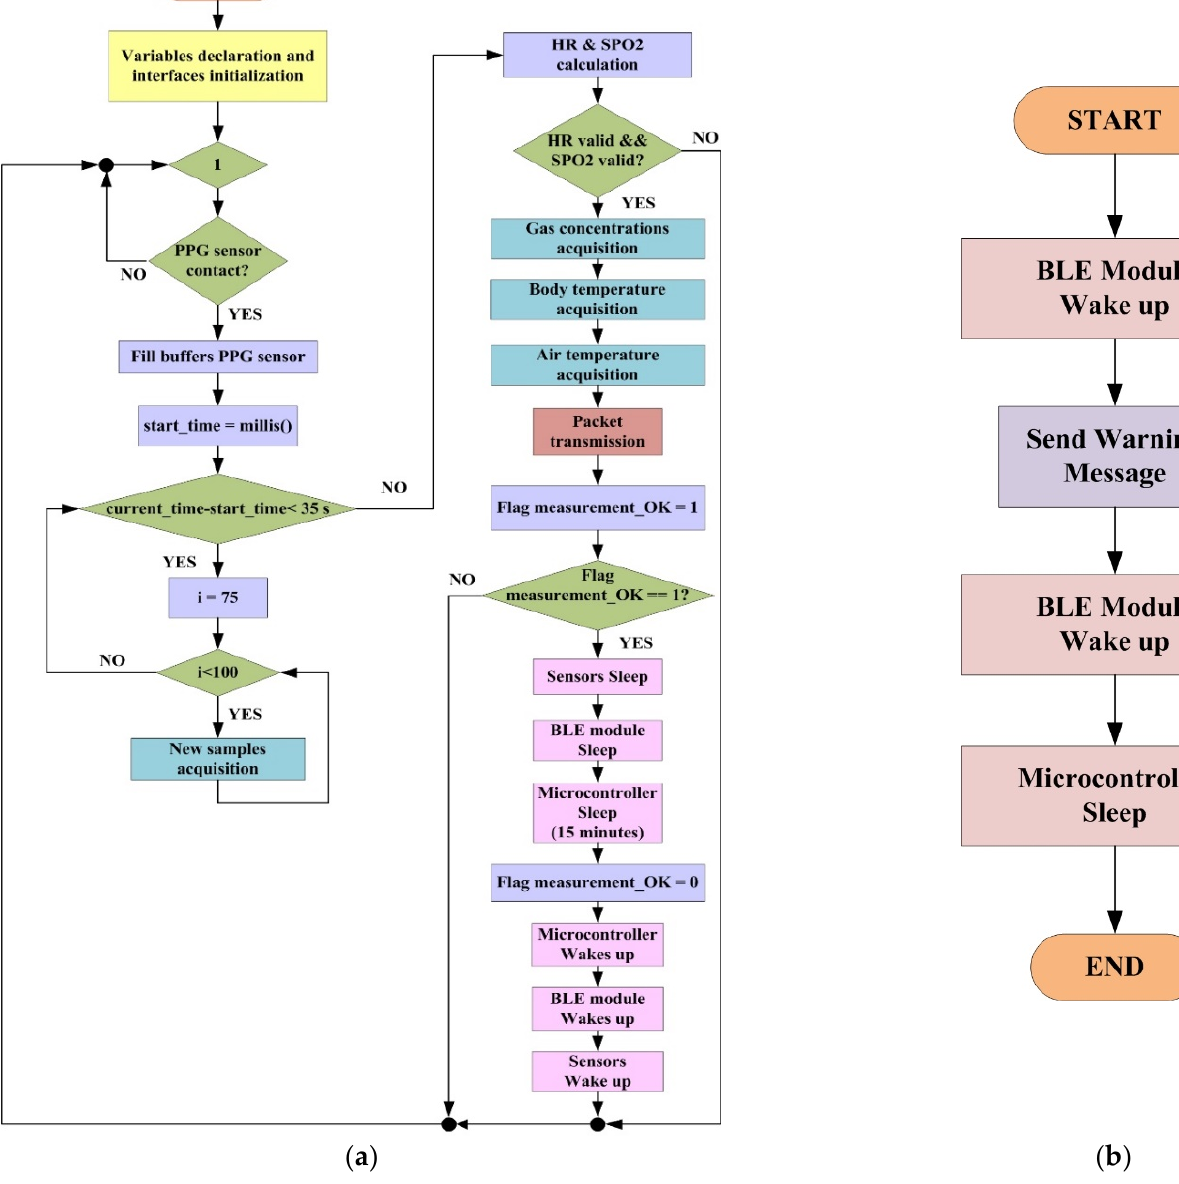
Figure 14. Flowchart of the firmware deployed by the wearable device ( a ); interrupt service routine (ISR) used to detect falls ( b ).